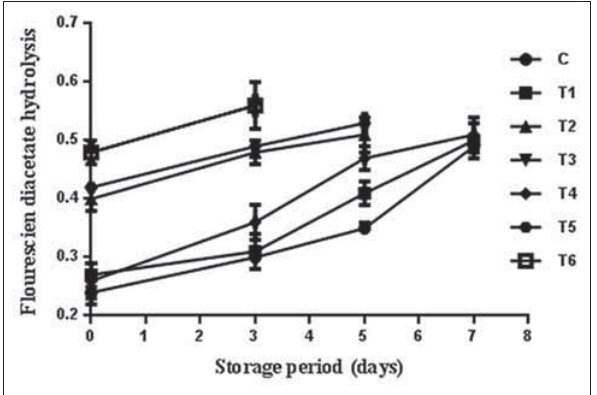
Figure-1: Changes in flourescein diacetate hydrolysis of control and treatment samples immediately after exposure study and on subsequent refrigerated storage (samples T3 and T6 was studied up to day 3 and T2 and T5 up to 5 days of refrigerated storage since meat was spoiled beyond these days for the respective